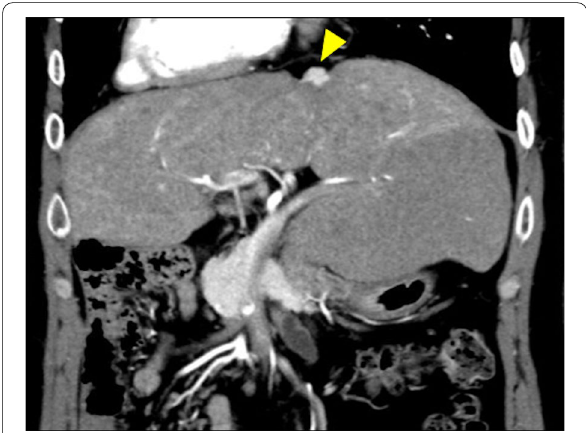
Fig. 1 Abdominal dynamic contrast-enhanced CT (arterial phase). Arrowhead shows the tumor protruding from the liver